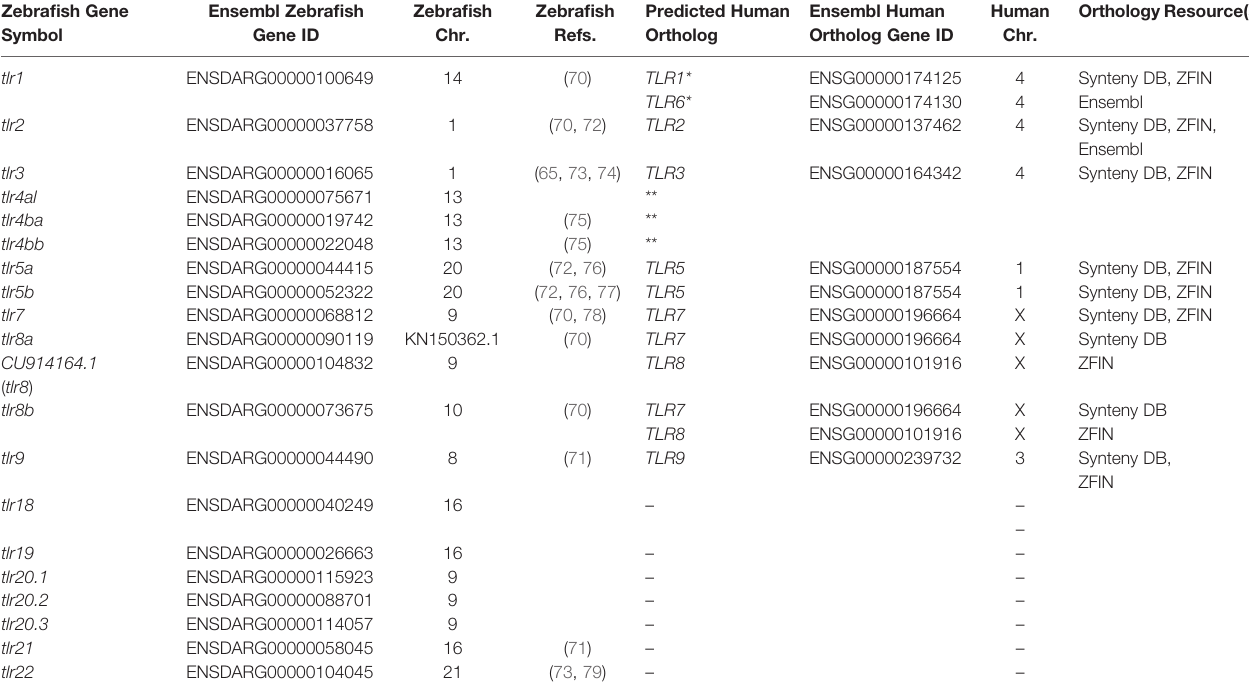
TABLE 3 | TLR genes in zebra fi sh. Zebra fi sh Gene